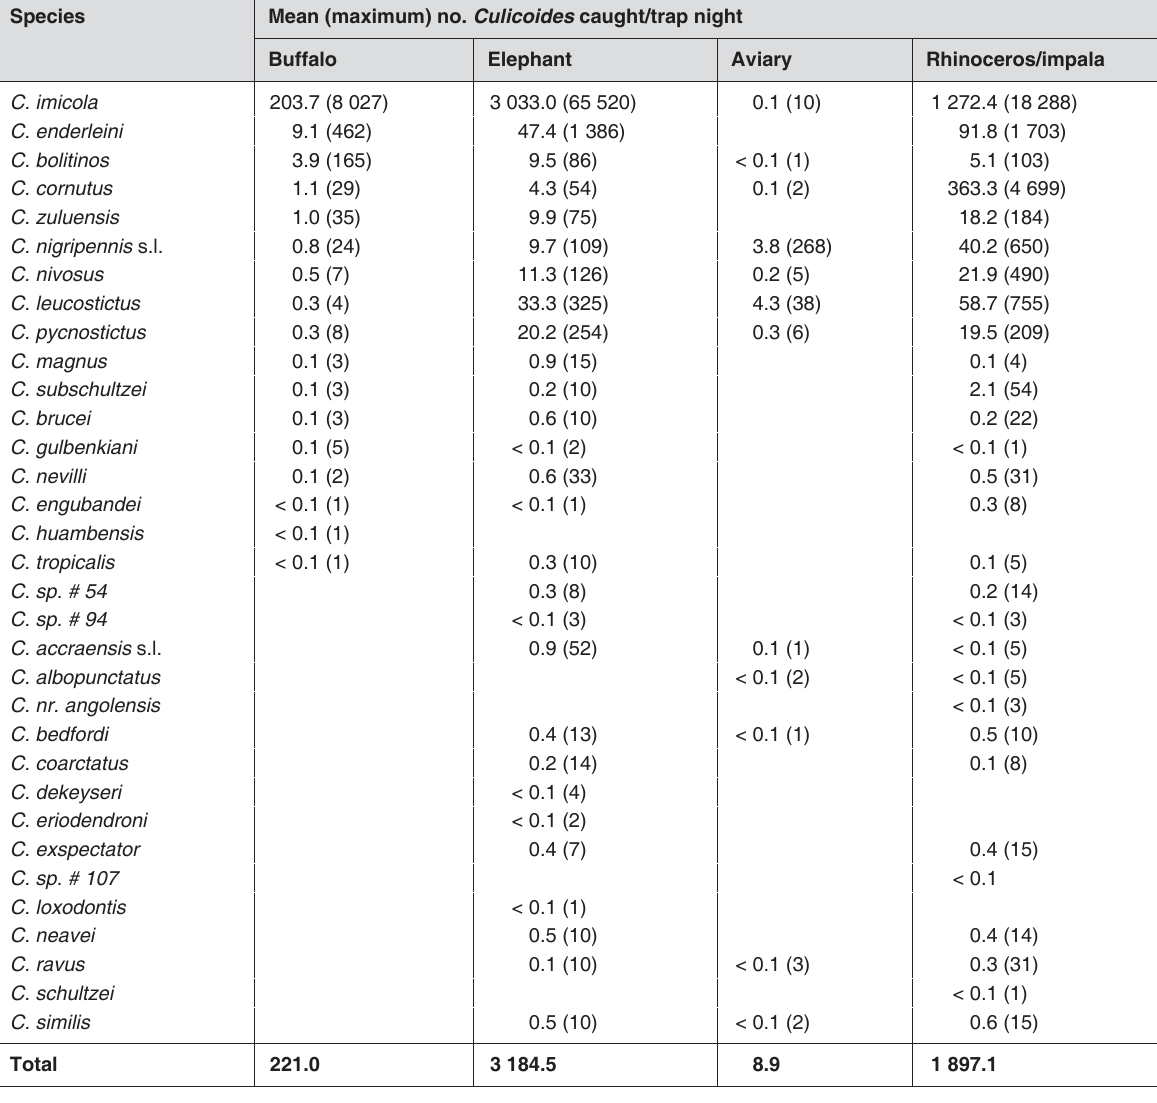
TABLE 1 Culicoides spp. recovered from 360 black light trap collections in the National Zoological Gardens, South Africa during August 2002 to August 2004